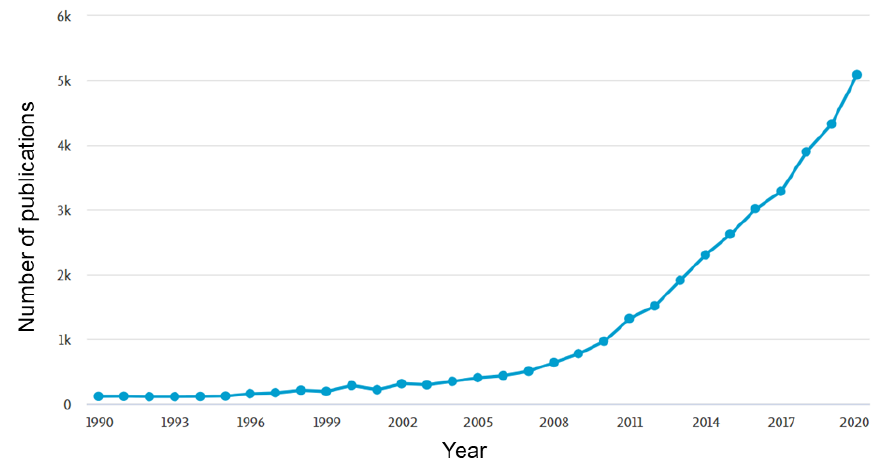
Figure 1. Number of publications mentioning biobased furans per year. Source: Scopus. Keyword: “furfural”.